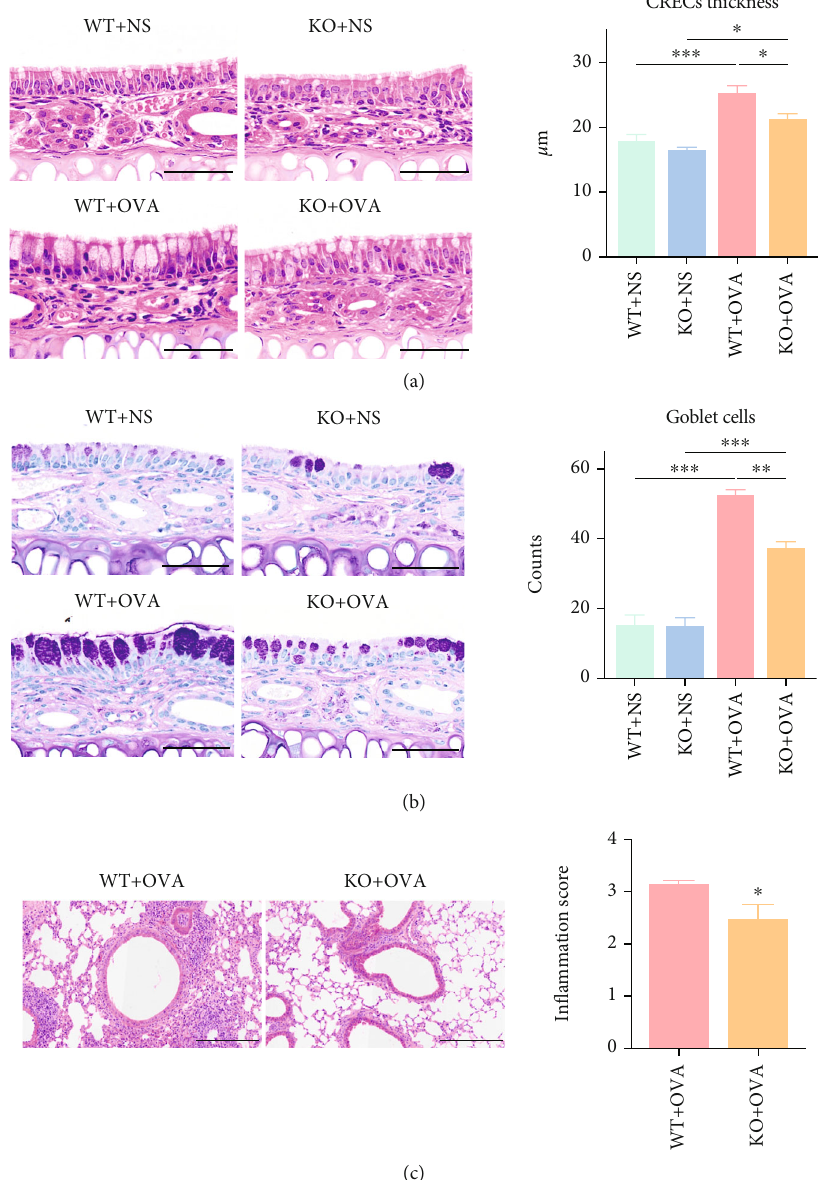
Figure 2: The de fi ciency of CD226 attenuates OVA-induced in fl ammation in nasal mucosa and lung in a mouse model of AR. (a) Representative images of HE staining and histopathology. Scale bar = 50 μ m. Quanti fi cation of thicknesses of CRECs in the nasal septum ( n = 3 ). (b) PAS staining and quanti fi cation of goblet cells in the nasal mucosa ( n = 3 ). Scale bar = 50 μ m. (c) Representative images of HE-stained lung sections and evaluation of in fl ammation scores ( n = 5 ). Scale bar = 200 μ m. AR: allergic rhinitis; OVA: ovalbumin; NS: normal saline; CRECs: columnar respiratory epithelial cells; HE: hematoxylin and eosin; WT: wild type; KO: knockout. ∗ P < 0 : 05 , ∗∗ P < 0 : 01 , and ∗∗∗ P < 0 : 001